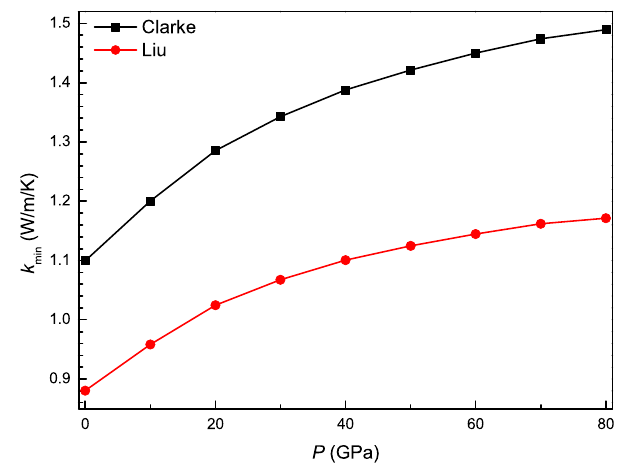
Figure 11. Minimum thermal conductivities as a function of pressure for Ti 3